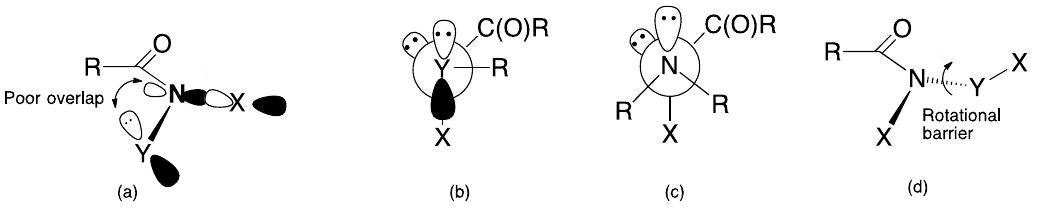
Figure 10. ( a ) sp 2 hybridised nitrogen hinders overlap with heteroatom Y in an n Y – σ * NX system; ( b ) optimum conformation in an n Y – σ * NX anomeric interaction; ( c ) optimum conformation in an anomeric interaction; and ( d ) restricted rotation about the N–Y bond in an n anomeric interaction.